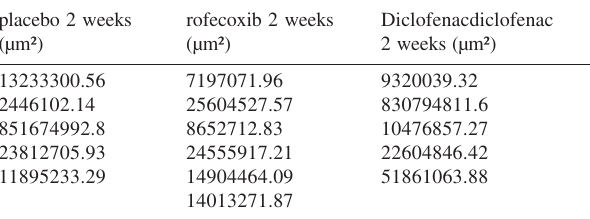
Table 6 - Total area (µm²)Absolute Values of bone callus, by animal, area of the groups at 2 weeks after osteotomy with 2 weeks